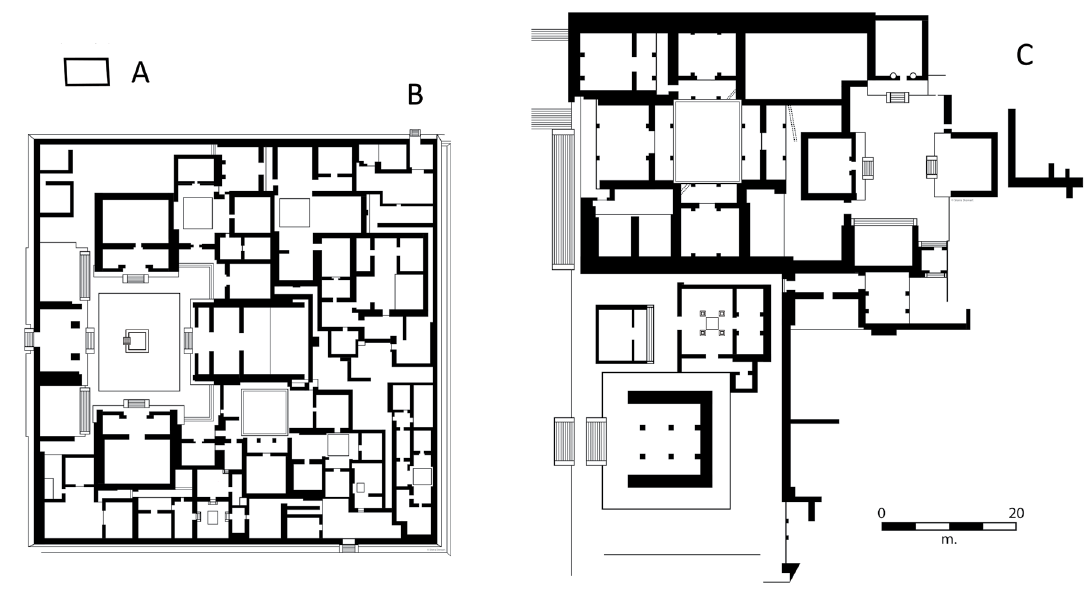
Figure 5. Teotihuacan housing. A: Early (Tzacualli period) one-room house. B: Yayahuala, a typical apartment compound. C: Viking Group, a civic structure with the kind of a patio-room block used in apartment compounds. A: Redrawn from Blucher (1979: Fig. 4) by the author. B, C: Plans by Sierra Stewart, redrawn from original unpublished plans by René